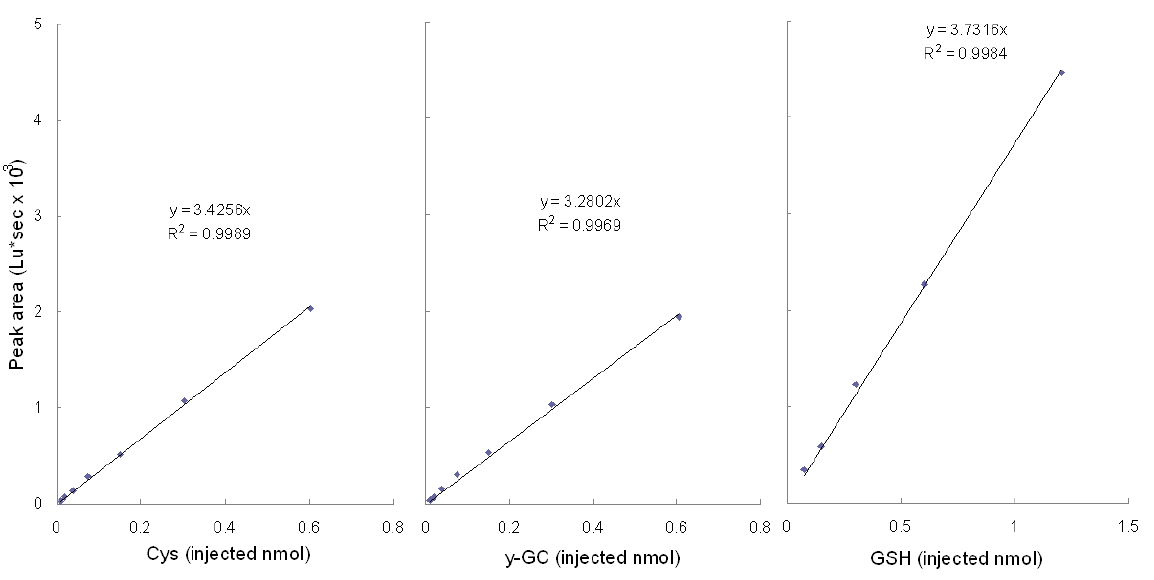
Figure 6. Calibration curves for Cys, γ -GC and GSH.